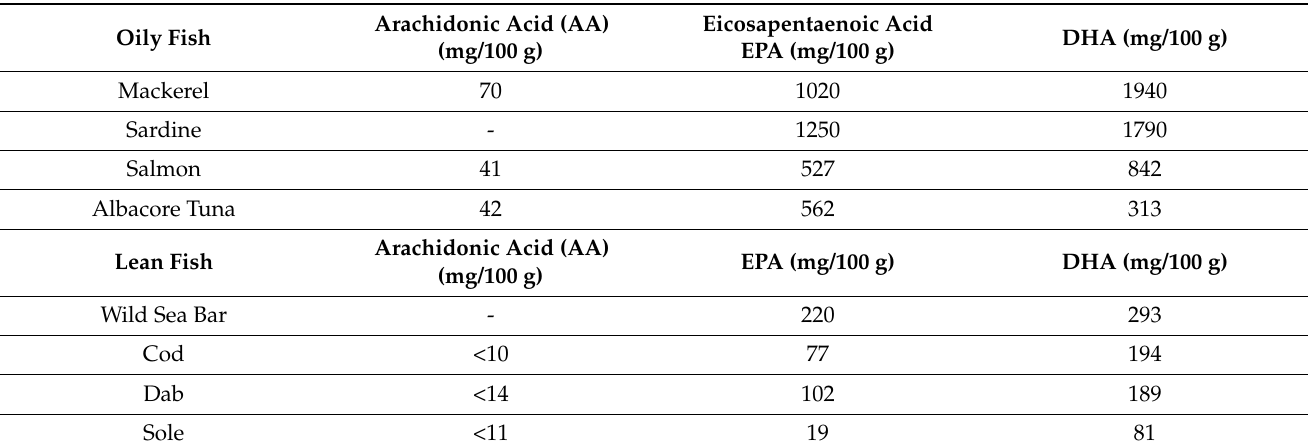
Table 3. Fish fatty acid